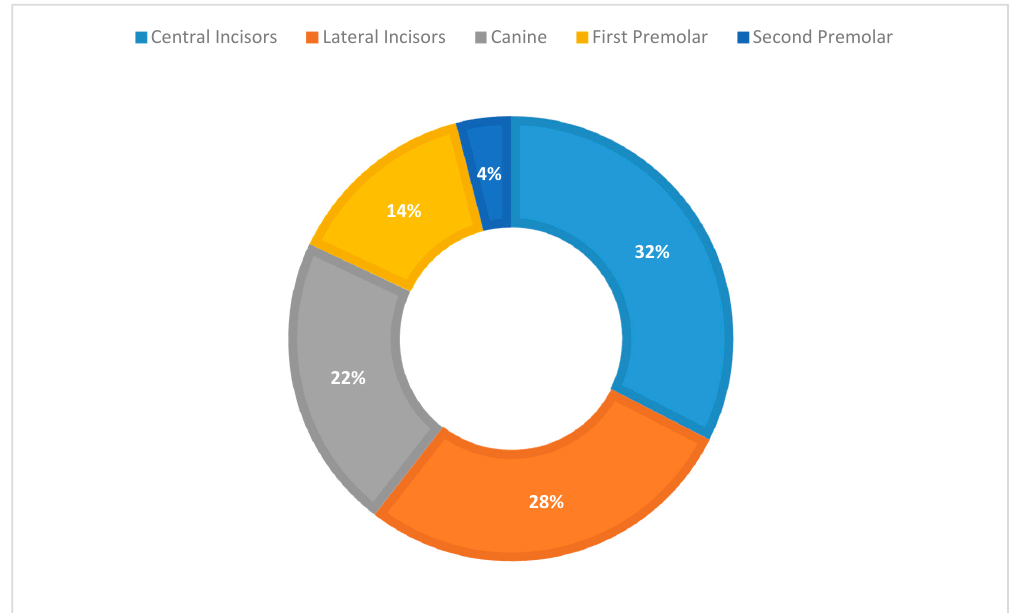
Figure 10. Distribution of lesions among teeth.